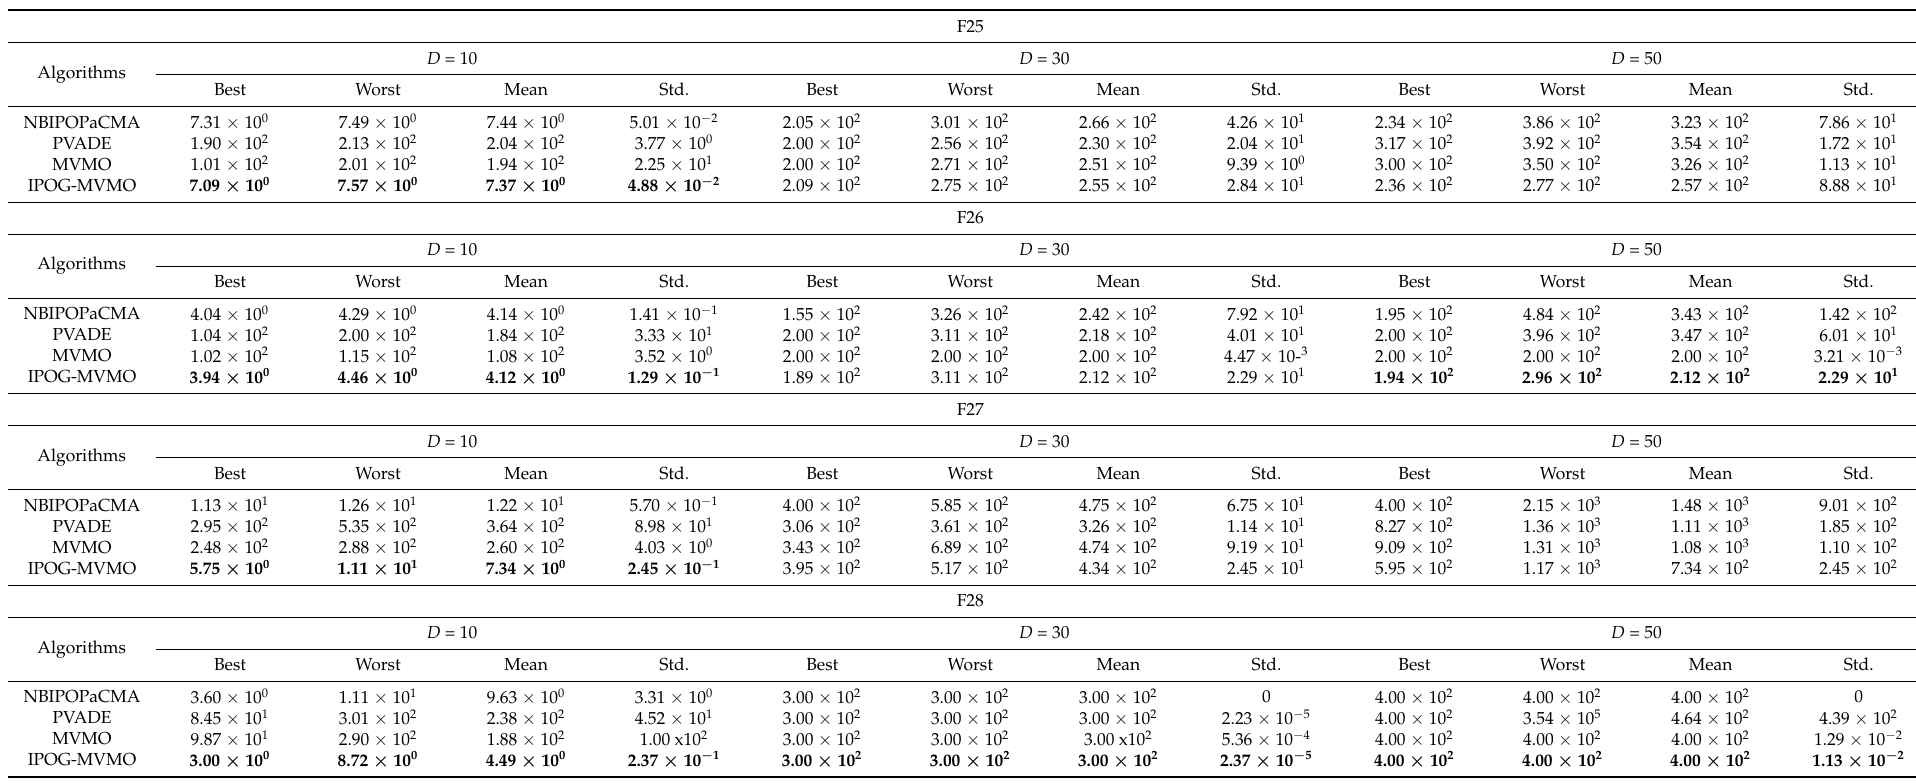
Table 8. The comparative results of the errors obtained from composition functions